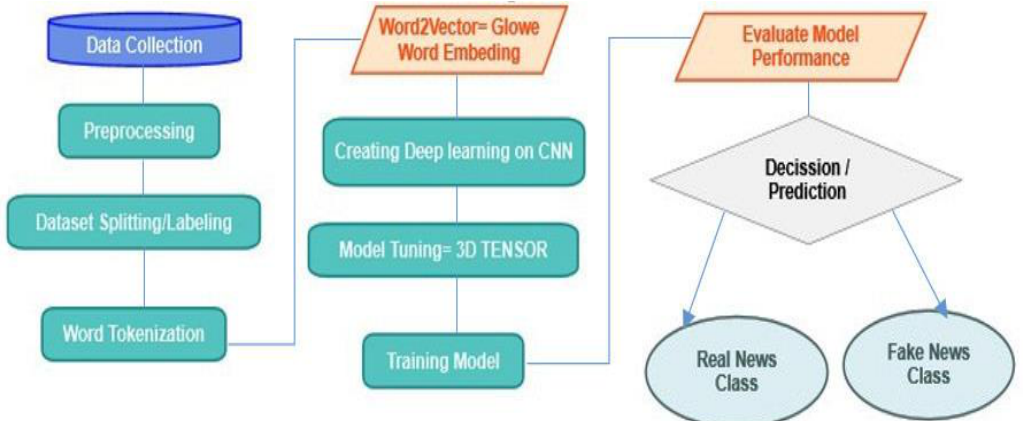
Fig. 3. Proposed framework for detecting fake news at sentence level based on 3D tensor-based